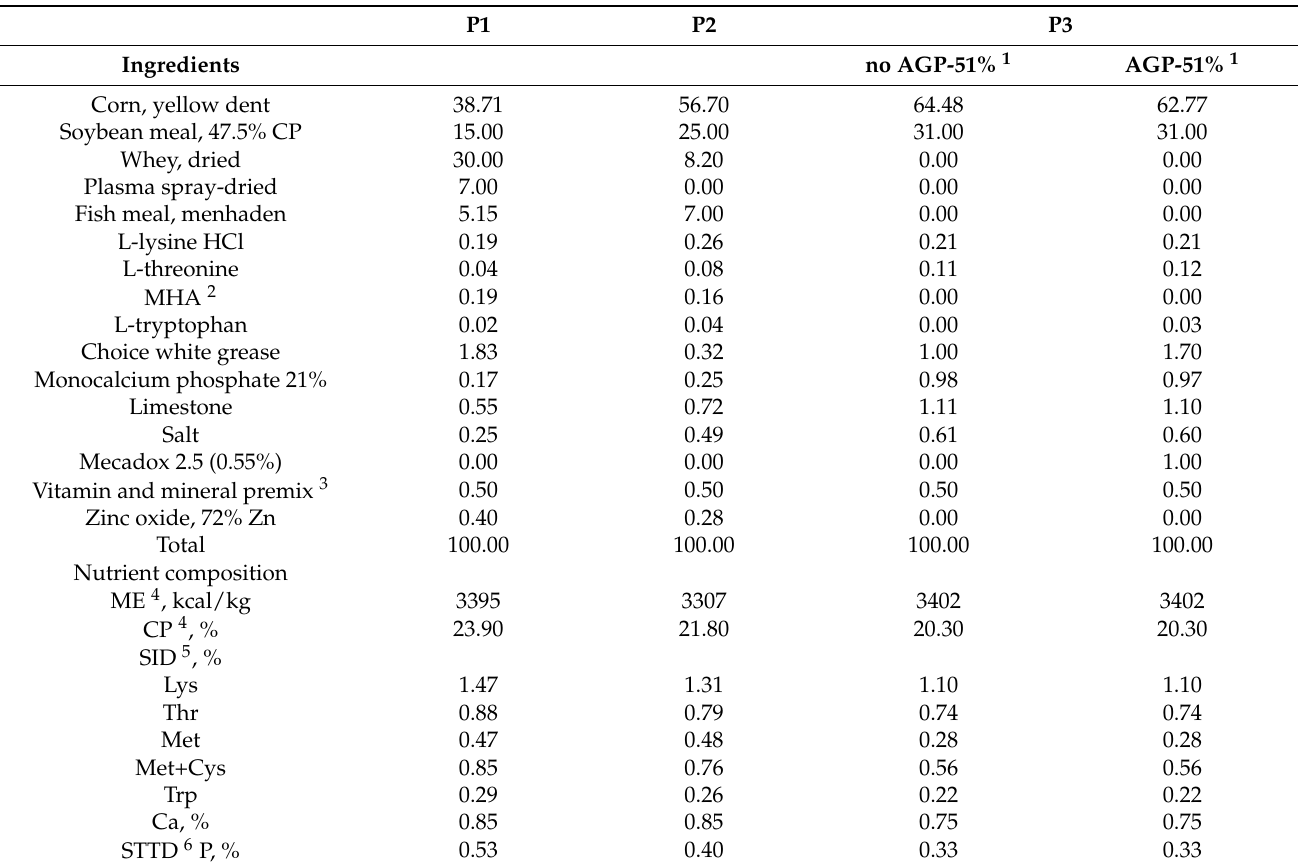
Table 1. Ingredient and nutrient composition of common diet in phases 1 and 2, and basal diets for phase 3 with 51% standardized ileal digestible total sulfur amino acid to lysine ratio (Experiment 1; as-fed